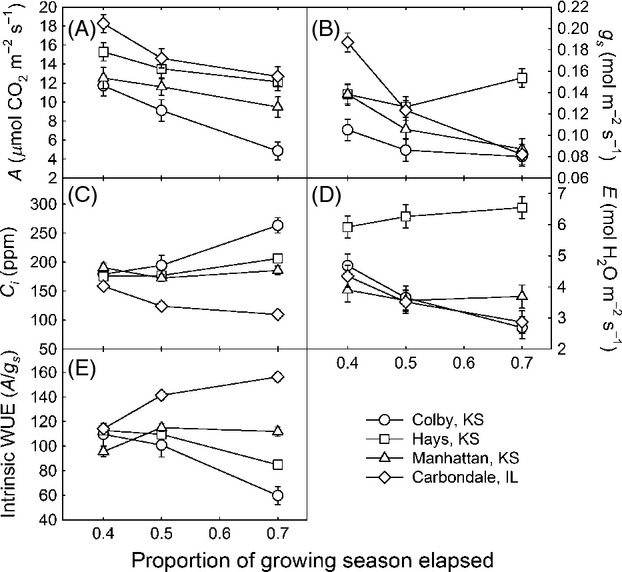
A Photosynthesis (A), gs Stomatal Conductance (B), Internal CO2 (Ci) (C), E Transpiration (D), and Intrinsic water-use efficiency (WUE, E, calculated as A/gs) of Andropogon gerardii ecotypes grown in Colby, KS (circle), Hays, KS (square), Manhattan, KS (triangle), and Carbondale, IL (diamond) planting sites in 2010 (least squares mean estimates ± SE) plotted over growing degree days, expressed as a proportion of elapsed season. All measures were made at 1500 μmol photons m−2 s−1. Points are means of four replicate plots ± SE.